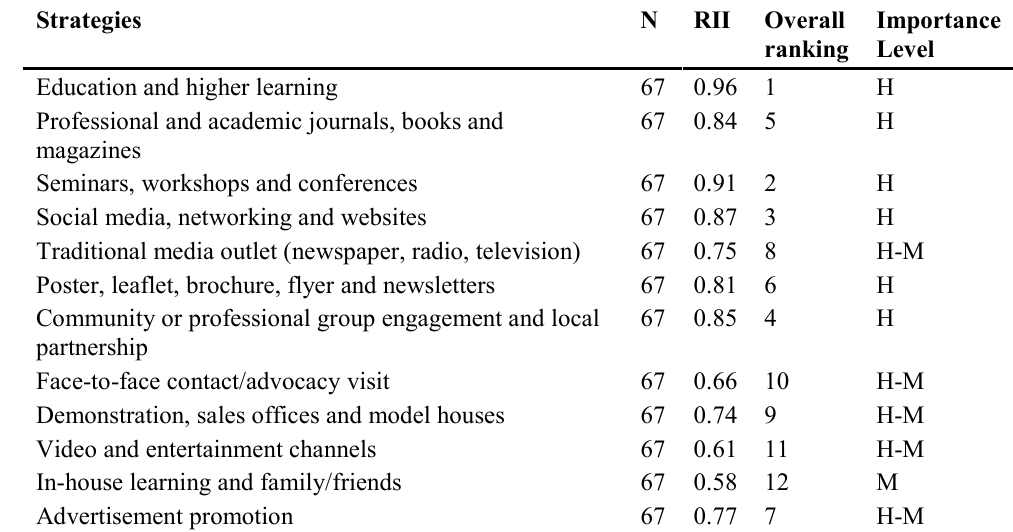
Table 6. Importance of Strategies for Optimising Awareness of Benefits of Sustainable Construction Practices Strategies N RII Overall ranking